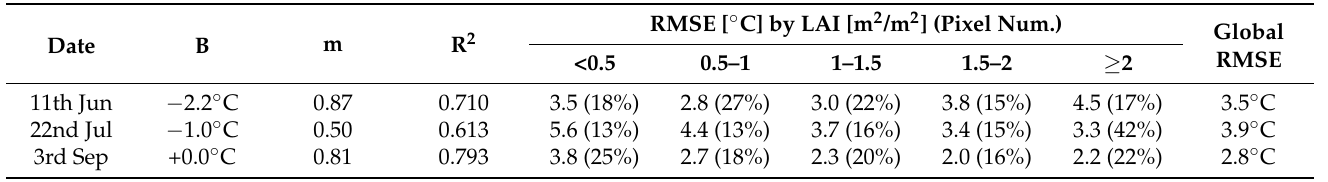
Table 3. Calibration statistics: Bias (B), linear interpolation slope (m) and determination coefficient (R 2 ) on a global level. Root-Mean-Square-Error (RMSE) global and sorted by Leaf Area Index (LAI).